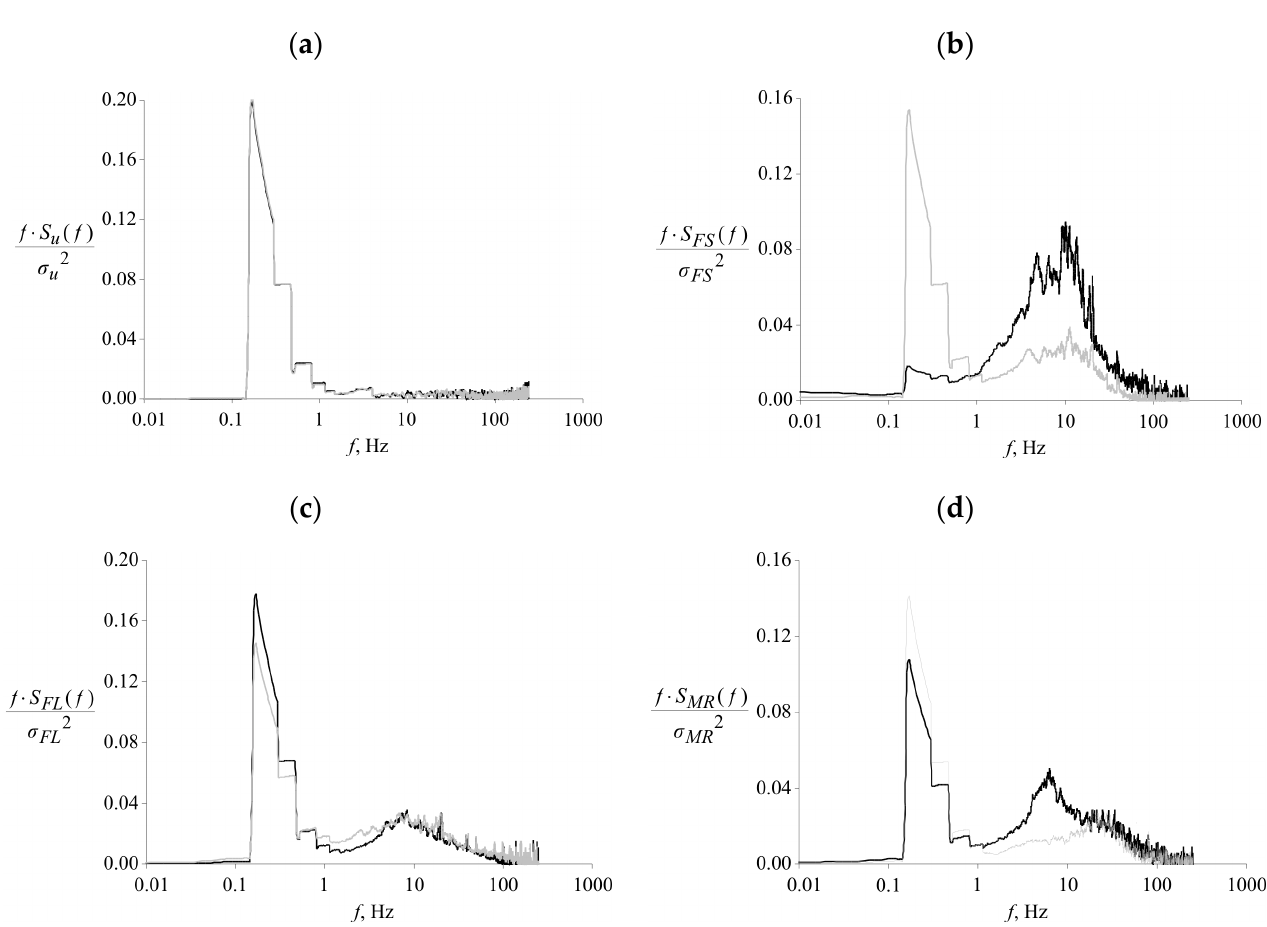
Figure 3. Power spectral density of ( a ) longitudinal velocity fluctuations, ( b ) side force fluctuations, ( c ) lift force fluctuations and ( d ) overturning moment fluctuations; in all diagrams, the black solid line is for model A and the grey solid line is for model B.